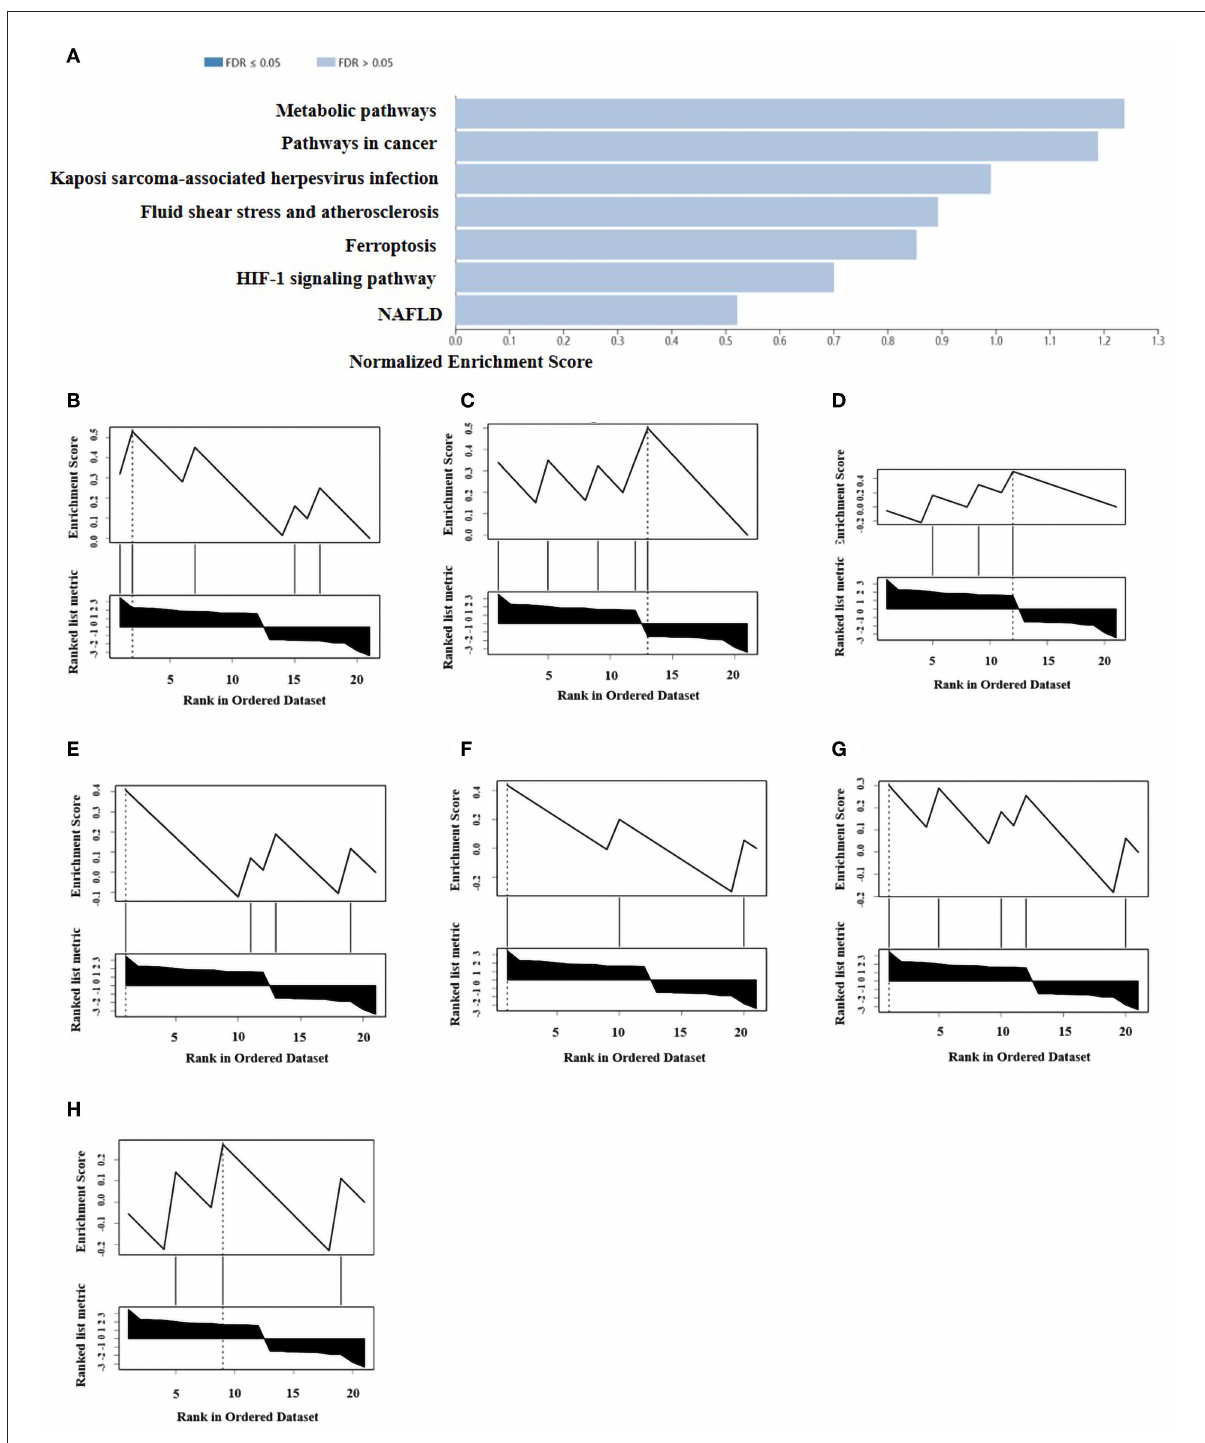
FIGURE2 GSEA and KEGG pathway analysis of the ferroptosis DEGs. (A) Pathways enriched of the ferroptosis DEGs by GSEA and KEGG analysis. Enrichment results (weighted set cover) indicated the genes significantly enriched were linked to several signaling pathways. (B) Enrichment plot: metabolic pathway. (C) Enrichment plot: pathways in cancer. (D) Enrichment plot: Kaposi sarcoma-associated herpesvirus infection. (E) Enrichment plot: fluid shear stress and atherosclerosis. (F) Enrichment plot: ferroptosis. (G) Enrichment plot: HIF-1 signaling pathway. (H) Enrichment plot: NAFLD. WebGestalt was used in GSEA of ferroptosis DEGs for visualization, which filtered the genes according to the number of genes contained in the gene set, with the ranges of gene number from 3 to